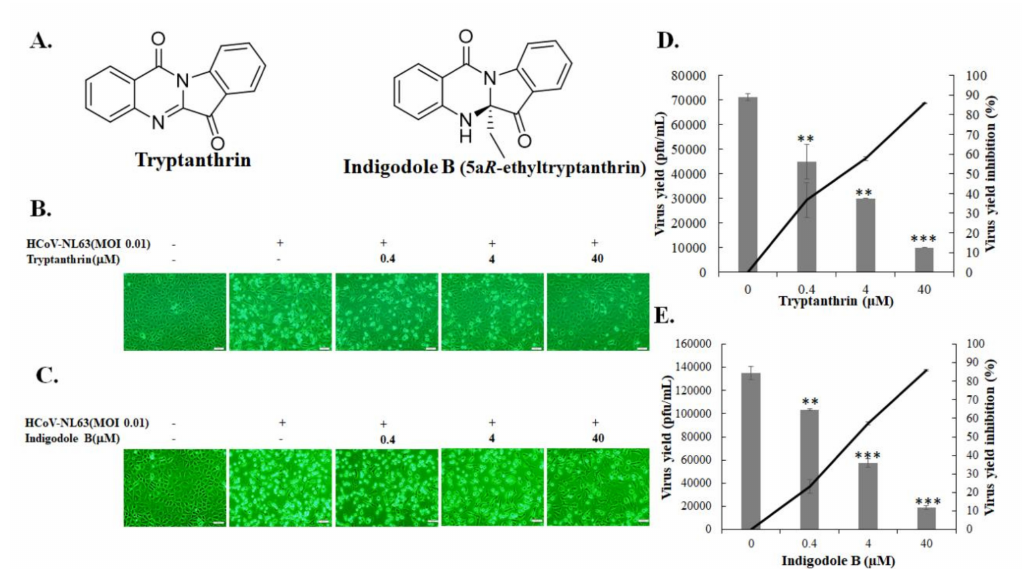
Figure 4. Inhibition of viral cytopathicity and virus yield by tryptanthrin and indigodole B. The structure of tryptanthrin and indigodole B is shown in ( A ). Images of CPE reduction by tryptanthrin and indigodole B were captured 36 hpi ( B , C ). The inhibitory activity of tryptanthrin and indigodole B on virus yield was calculated based on the ratio of titer loss in the treated group to that in the mock-treated group ( D , E ). + , add; − , not add; **, p value < 0.01; ***, p value < 0.001 compared with untreated infected cells. Scale bar, 100 µ